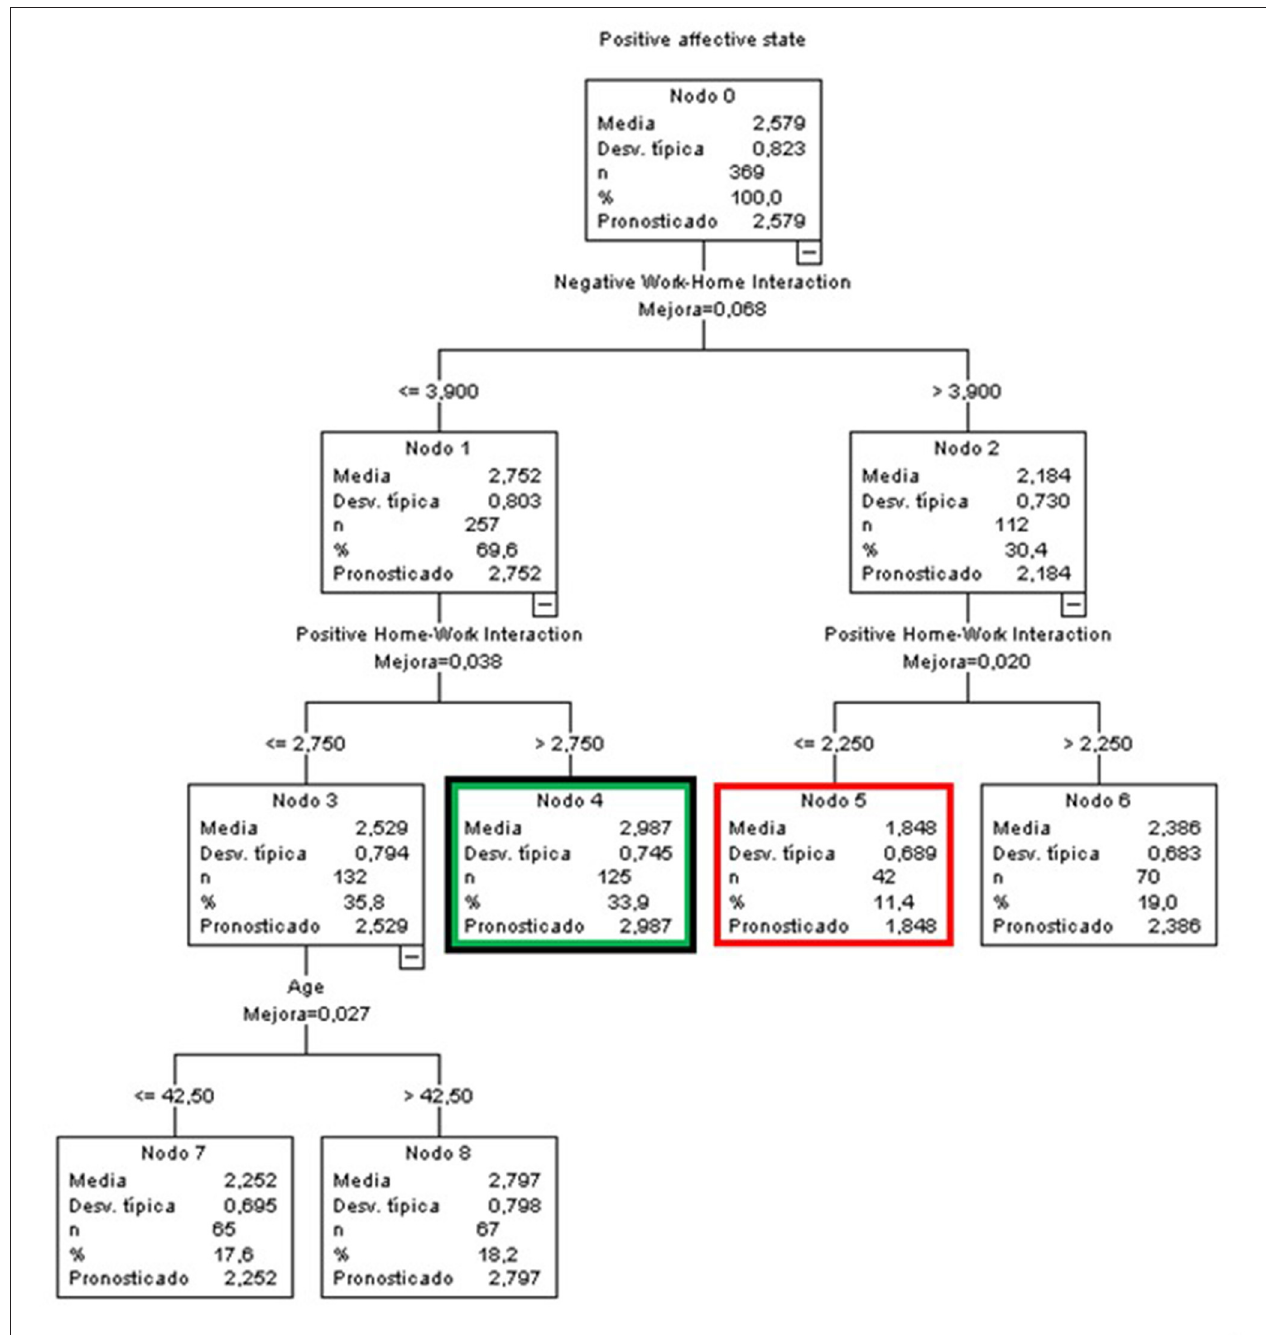
FIGURE 8 | Classificatory tree of positive affective states (Men).